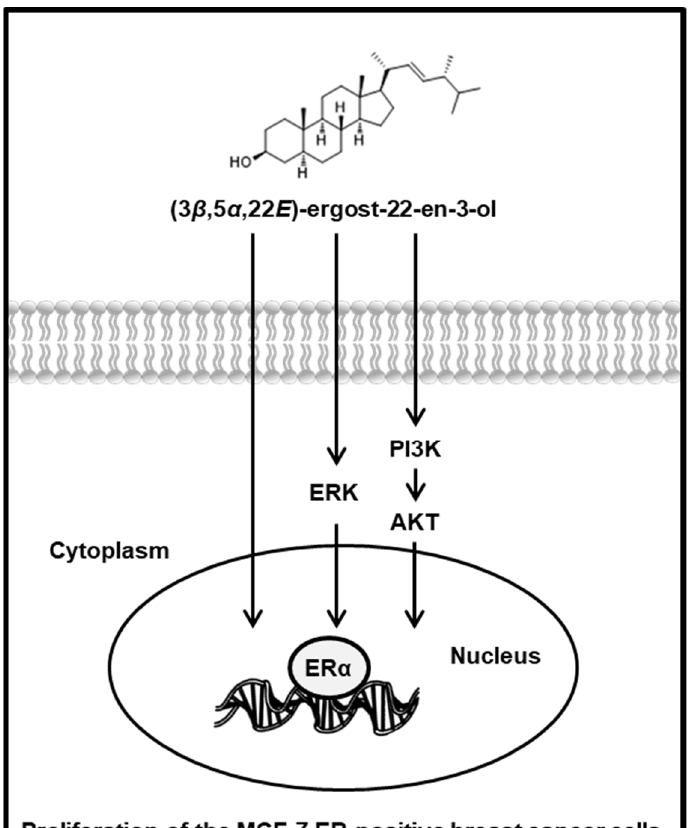
Figure 8. Schematic illustration of the underlying mechanism of the estrogenic activity of (3 β ,5 α ,22 E )-ergost-22-en-3-ol via estrogen receptor α (ER α )-dependent signaling pathways in MCF-7 estrogen-receptor-positive breast cancer cells.